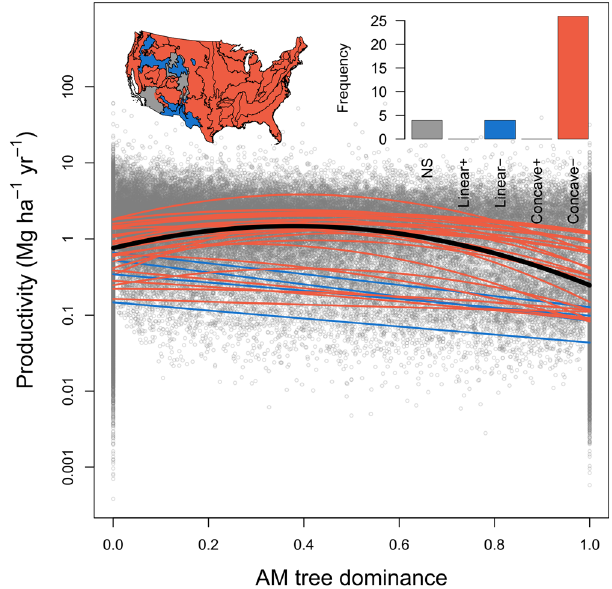
Fig. 2 | Observed relationship between AM tree dominance and forest pro- ductivity. AM tree dominance is quanti fi ed as AM proportion based on tree basal area.Theblackcurvewassimpleregression fi ttedacrossallforestplots,whereasother curvesweresimpleregressions fi ttedforplotswithineachecoregion.Eachgreycircle represents the data of one forest plot ( n =74,563). Inset frequency chart: The fre- quencies of each form of relationship observed across all ecoregions. Inset map: The coloredmapindicatesthedistributionofeachformofrelationshipacrossecoregions. The signi fi cance of the relationships in the frequency chart and colored map was based on regressions with environmental variables fi tted as covariates. NS non- signi fi cant. See Supplementary Table S1 for overall statistical results and Supple- mentary Data 1 and Supplementary Fig. S14 for results and fi gures of each